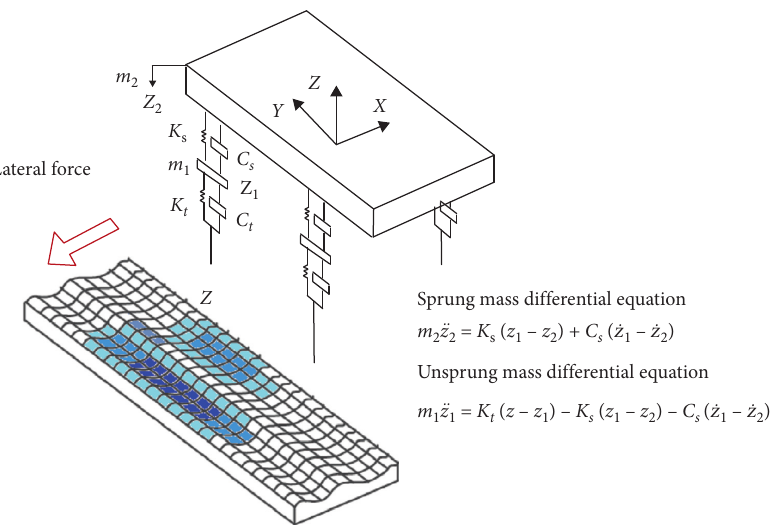
Figure 8: 3D differential equation model of the vehicle pavement with multidegree of